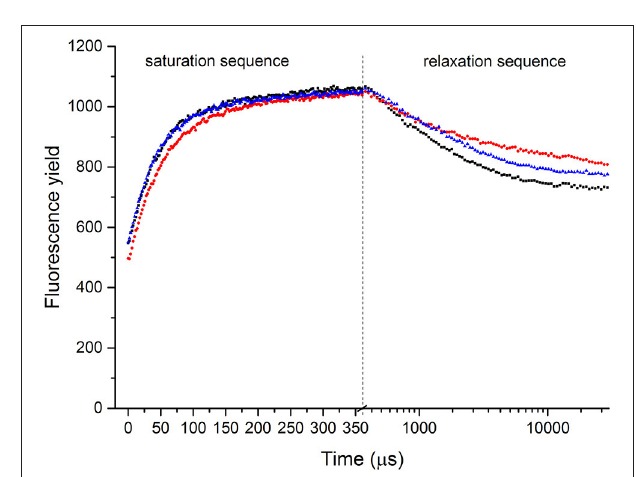
FIGURE 5 | Effect of the Calvin-Benson cycle inhibitor glycolaldehyde (GA) on P700 kinetics. Control nubbins were measured in the absence of the inhibitor ( − GA, black line), then the same nubbins were incubated with 5 mM GA ( + GA) and P700 measurements were performed at different time points: 50 min, red line; 2 h, blue line; 4.5 h, orange line. The same illumination protocol was applied as shown and described in Figure 1 . P700 + signal intensity is shown in relative units as [P700 + ] (relative).